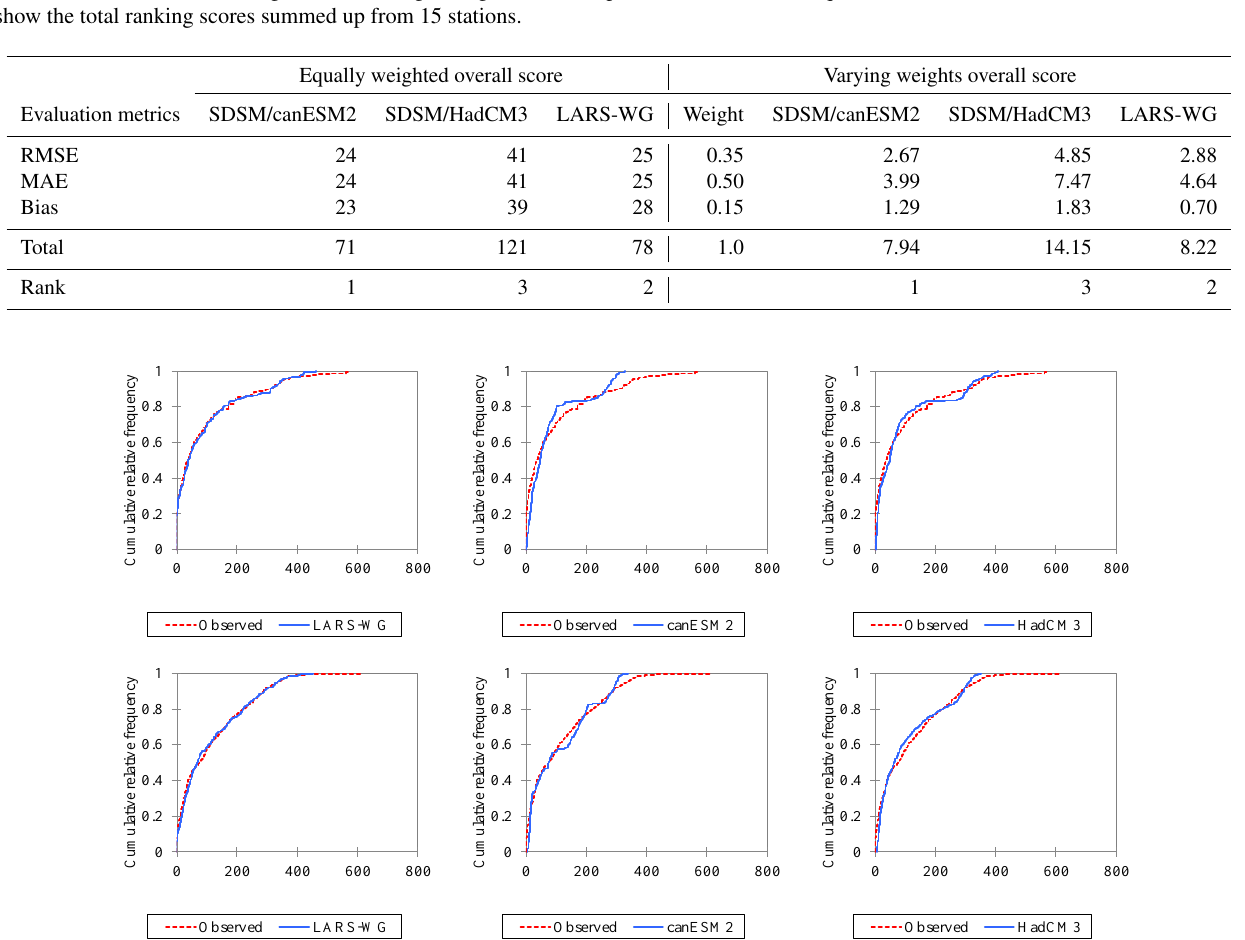
Figure 9. Kolmogorov–Smirnov test to compare the skill of the models for the observed precipitation distribution (upper three Alemketema stations, lower three Debre Markos